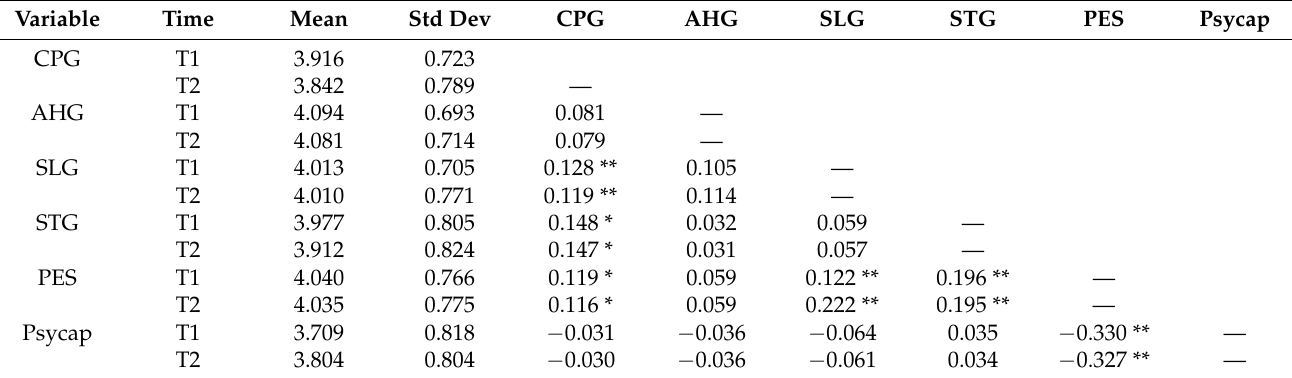
Table 3 presents the mean, standard deviation, and correlations at T1 and T2. Table 3. Descriptive and Pearson correlations matrix (T1) and Pearson correlations matrix (T2).